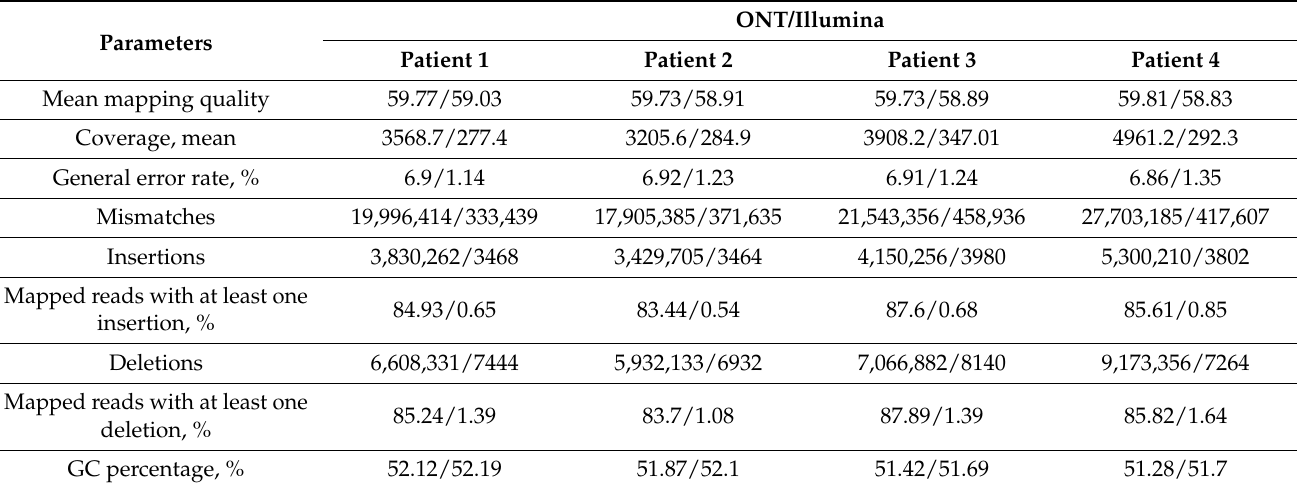
Table 1. Sequencing and alignment statistics for ONT and Illumina sequencing methods in four